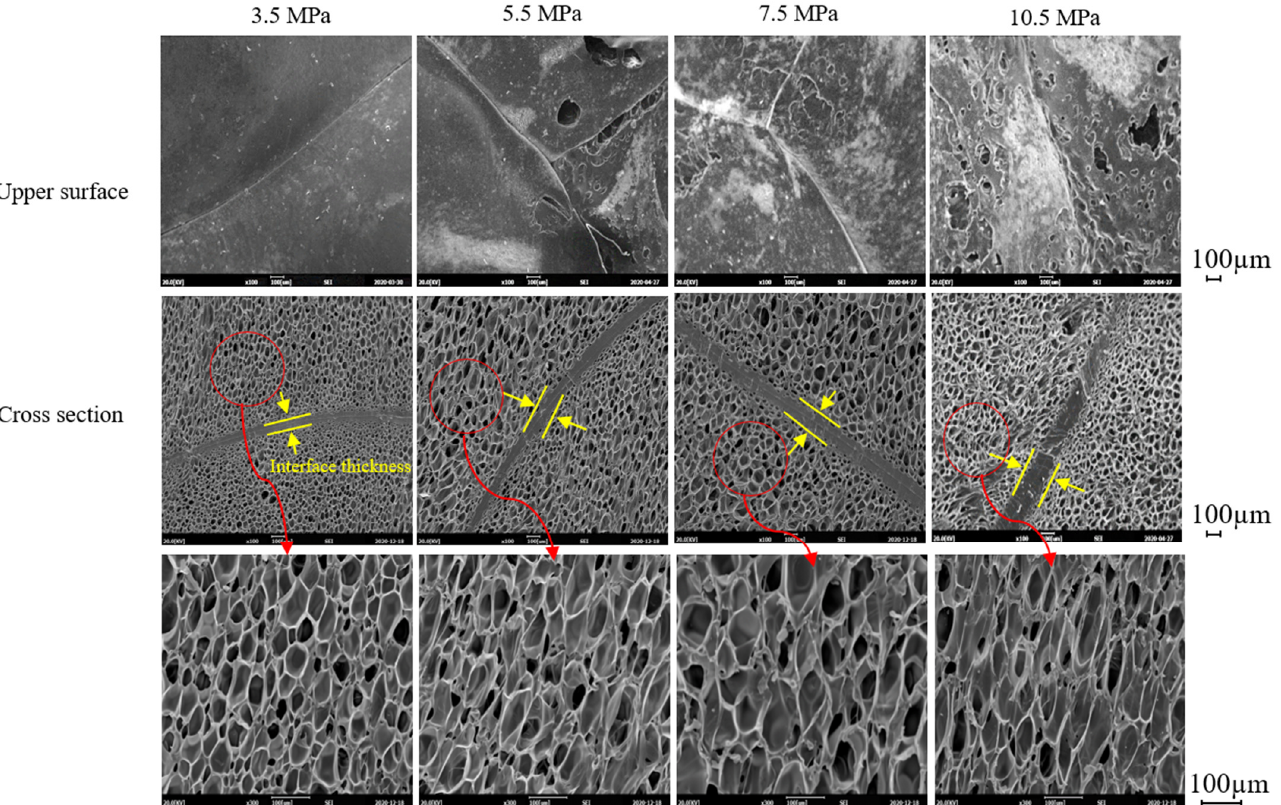
Figure 7. Effect of compression molding pressure on the sintering of ETPU beads at 145 °C.